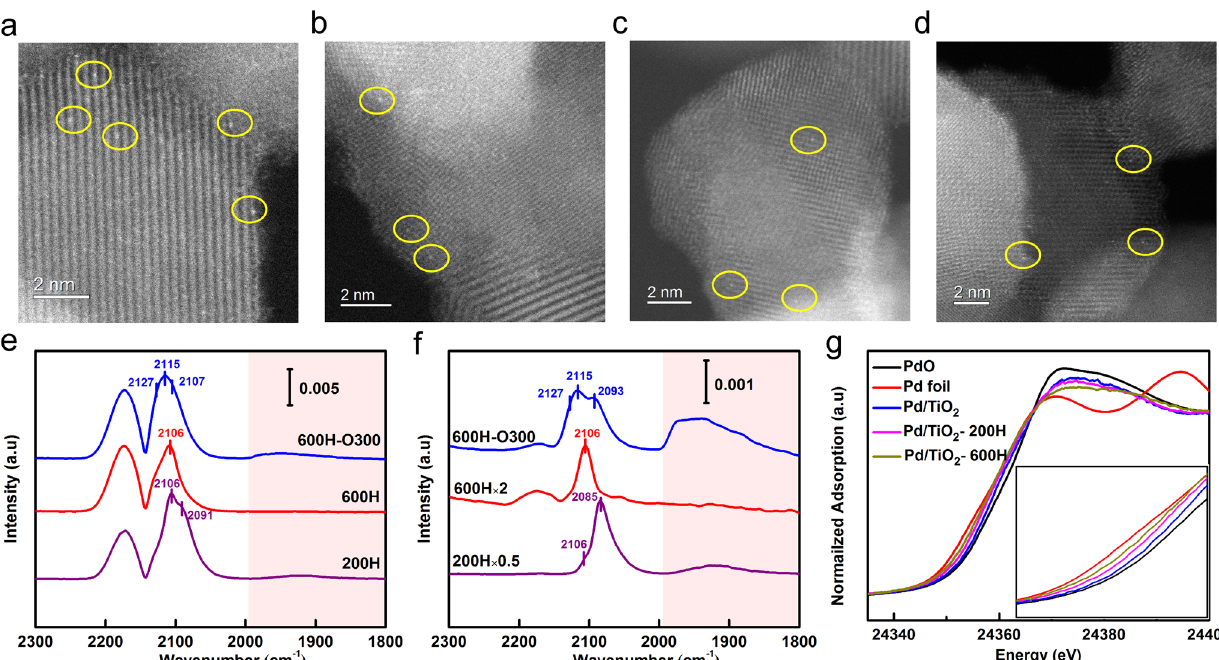
Fig. 1 Structural characterization of Pd/TiO 2 serial catalysts. a – d AC-HAADF-STEM images of a Pd/TiO 2 , b Pd/TiO 2 -200H, c Pd/TiO 2 -600H, and d Pd/ TiO 2 -600H-O300; Pd single atoms are highlighted in yellow circles. e , f DRIFT spectra of CO adsorption on Pd/TiO 2 -200H, Pd/TiO 2 -600H, and Pd/TiO 2 - 600H-O300 e at CO saturation adsorption and f upon He purging for 2.5 min at room temperature. g XANES spectra of different Pt/TiO 2 catalysts at Pd K-edge absorption